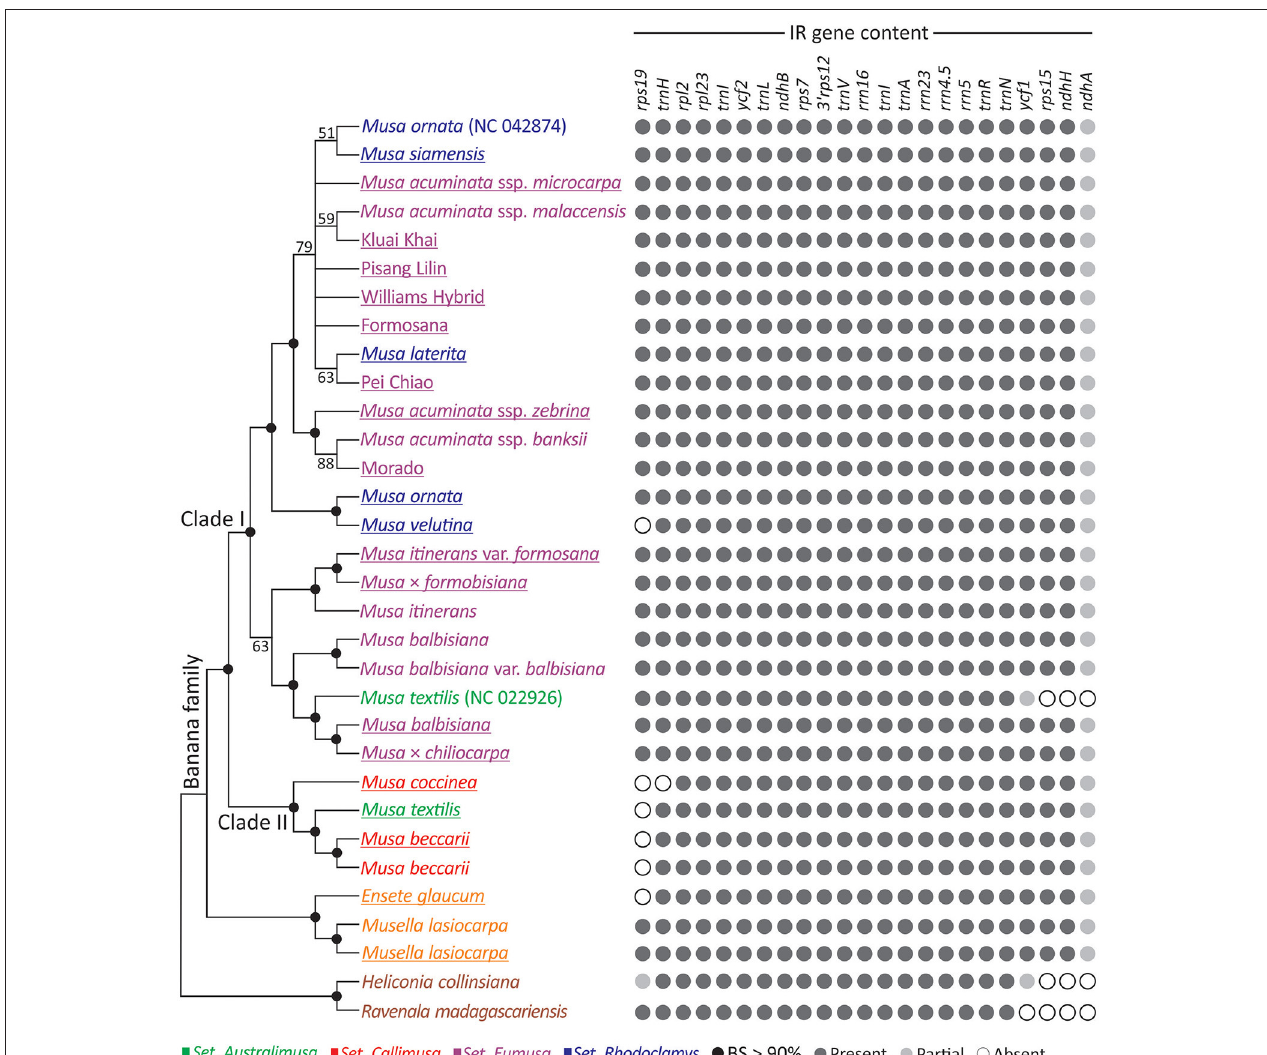
FIGURE 2 | Plastid phylogeny and IR gene content of banana species. An ML tree inferred from the concatenation of 83 plastid genes is shown in the left panel, while the IR gene content of the associated taxa is illustrated in the right panel. The underlined taxa are sequenced in this study. BS, bootstrap support.